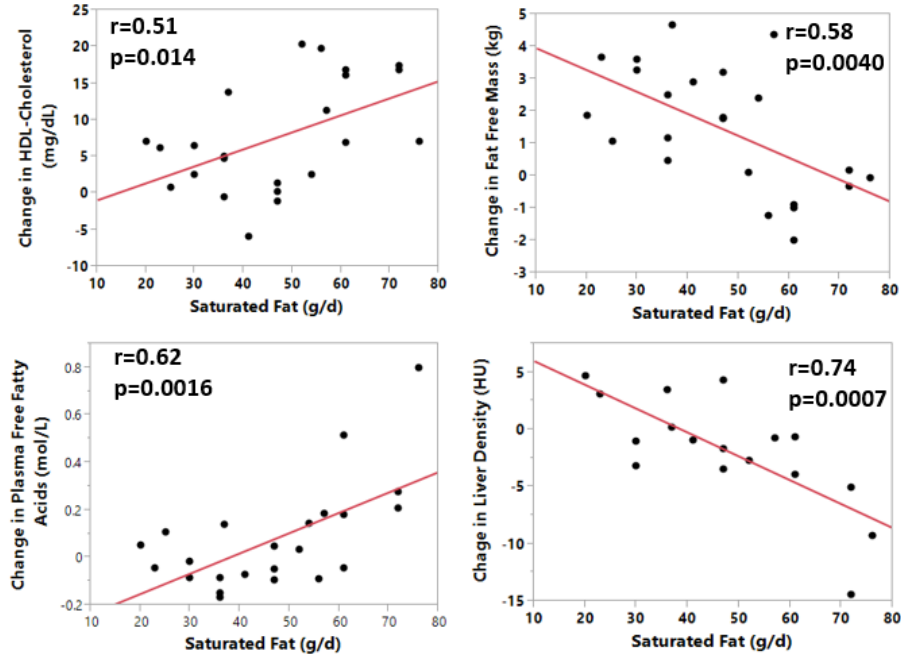
Figure 2. Relation of saturated fat intake to change in HDL-cholesterol, free fatty acids, fat-free mass, and liver fat during overeating.